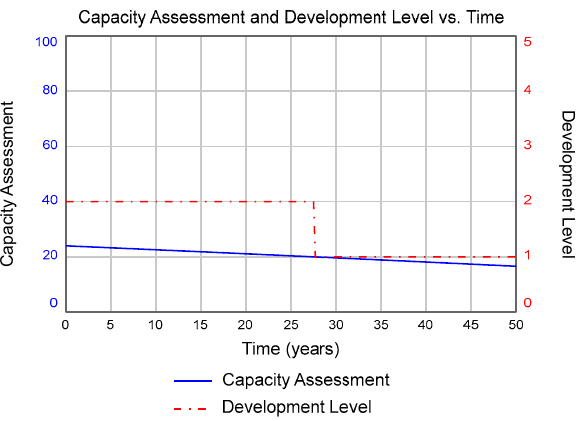
Figure 9. Variation of community capacity assessment and community capacity (development) level with time for a constraining environment.